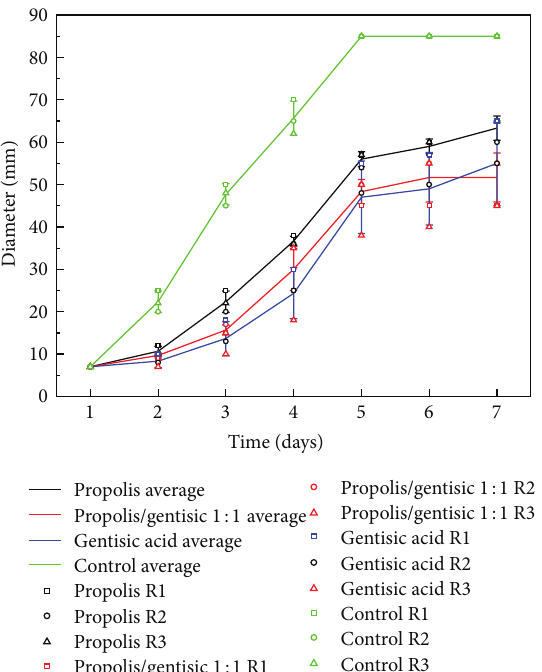
Figure 8: Comparison of the antifungal activity of pure propolis, a propolis: gentisic acid mixture (1: 1), and pure gentisic acid. R1, R2, and R3 stand for 1st, 2nd, and 3rd